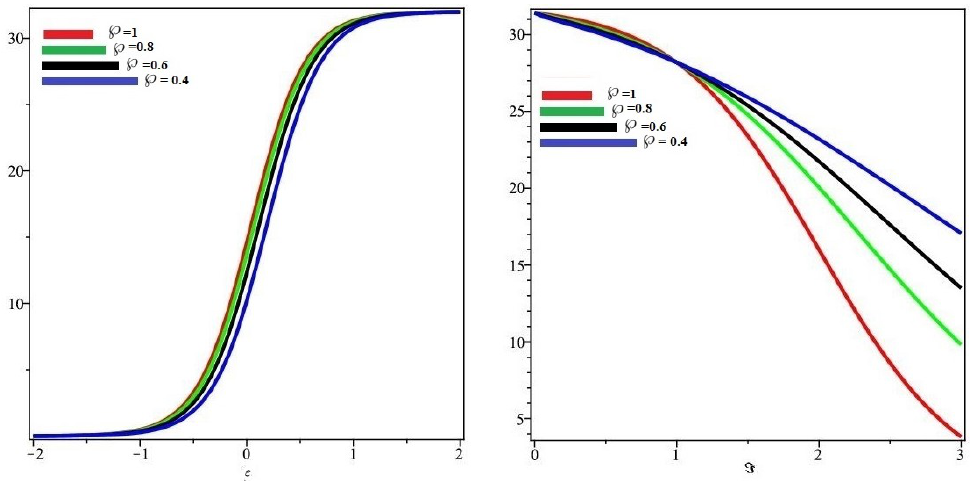
Figure 3. The fractional-order solutions of V ( ε , (cid:61) ) at ℘ of Example 1.